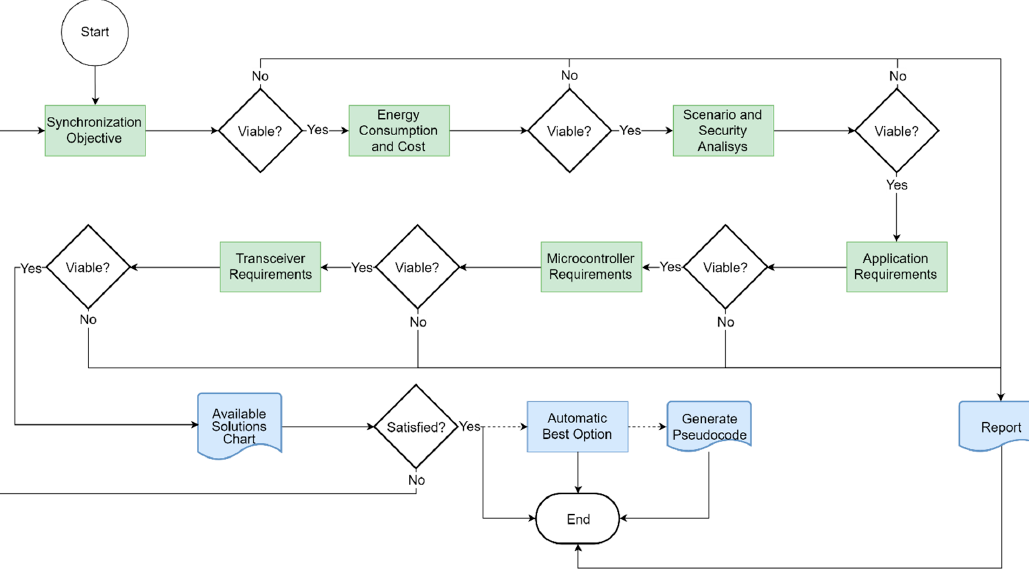
Figure 1. Flowchart of the proposed methodology where the input blocks are colored in green and the output blocks are filled in blue color. White blocks are those where the methodology makes decisions.